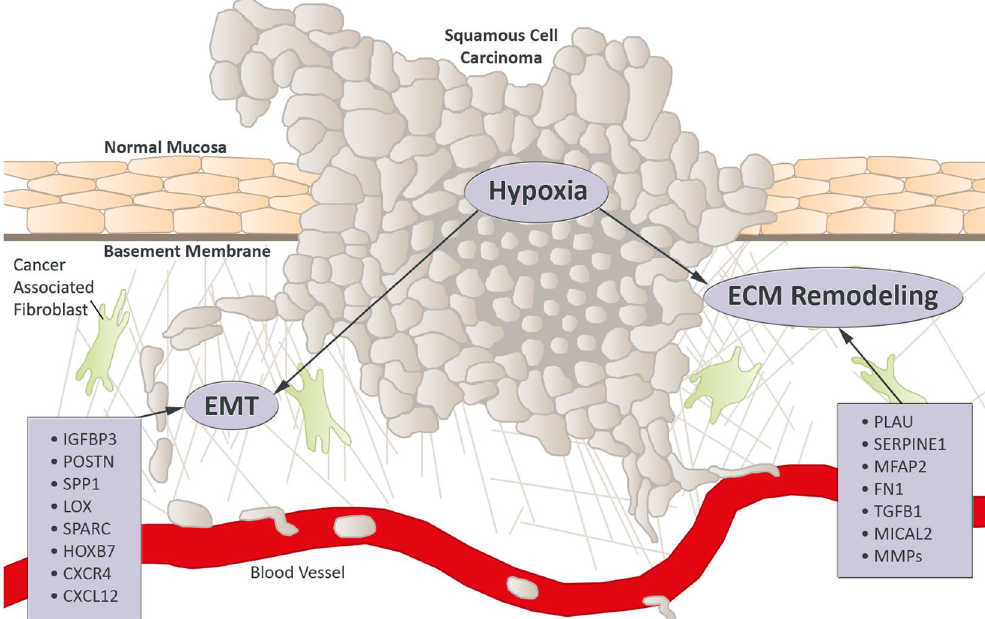
Figure 6. Potential prognostic biomarkers for HNSCC linked to hypoxia, EMT and ECM remodelling are directly connected. Hypoxic environments induce genes promoting an aggressive, invasive phenotype, mediated by epithelial to mesenchymal transition (EMT) and remodelling of the extracellular matrix (ECM). Matrix metalloproteinases (MMPs) and other proteases degrade the basement membrane and new collagen fibres are aligned by modifying enzymes to facilitate local invasion and recruitment of cancer associated